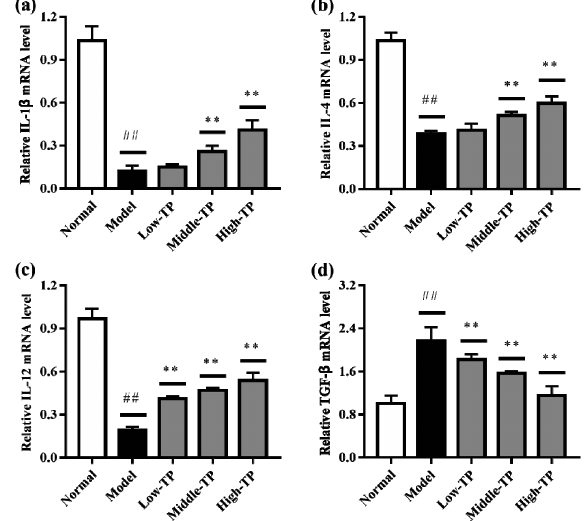
Figure 6. The levels of relative gene expression in spleen. ## p < 0.01, compared to Normal. ** p < 0.01, compared to Model. ( a ) IL-1 β expression level; ( b ) IL-4 expression level; ( c ) IL-12 expression level; ( d ) TGF- β expression level.